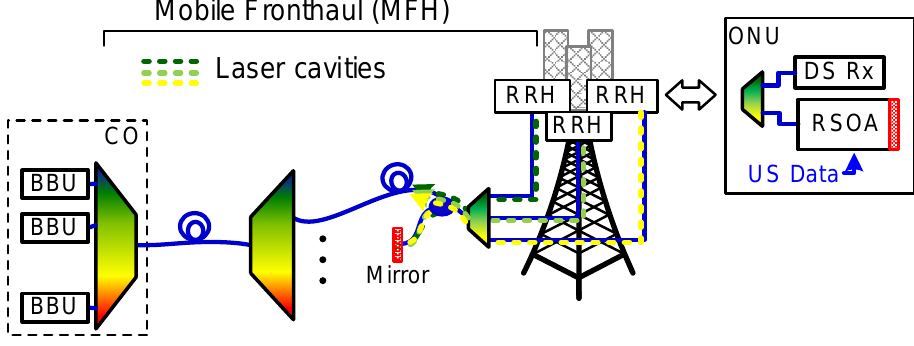
Figure 2. Arrangement of the self-seeded RSOA-FCL in a WDM-PON-based mobile fronthaul (MFH) network as an upstream transmitter. CO: central office, BBU: base band unit, US: upstream, DS: downstream, ONU: optical network unit, RRH: remote radio